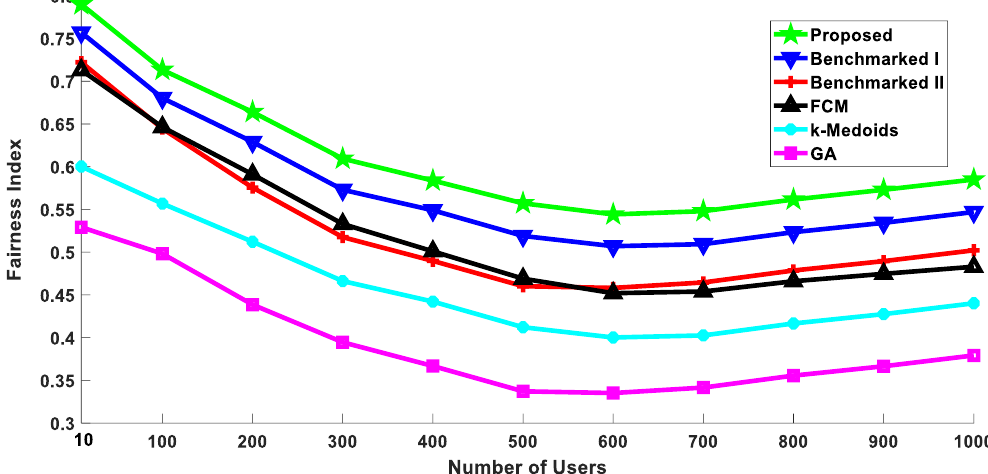
Figure 16. Jain’s Fairness Index: Comparison with the benchmarked ( 𝑤 1 = 𝑤 2 = 0.1,𝑤 3 = 0.8 ).